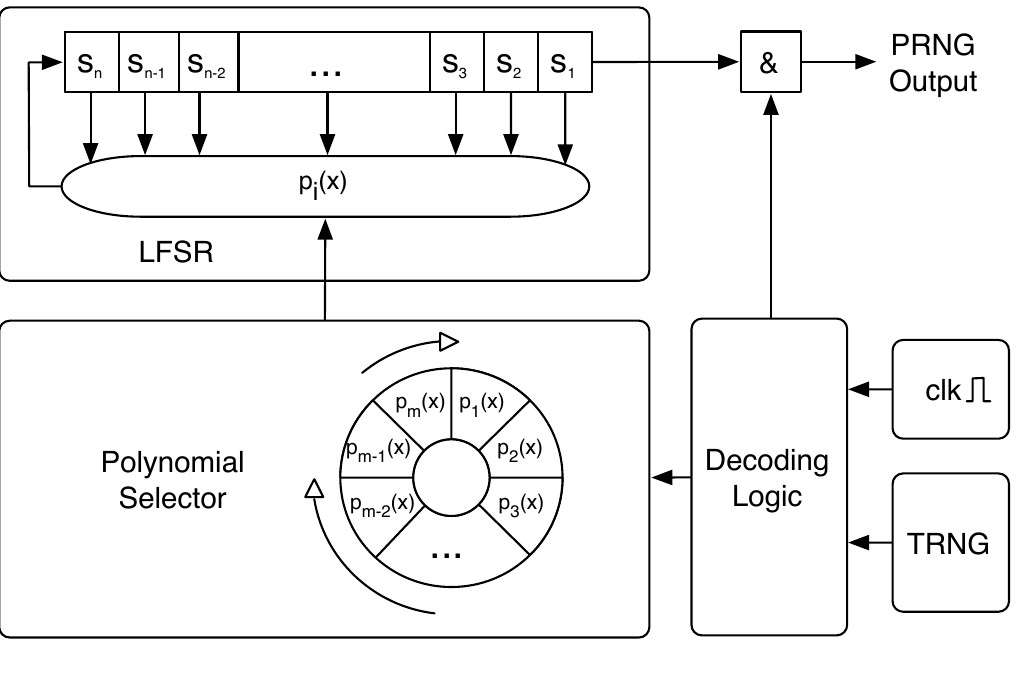
Figure 1. Block diagram of